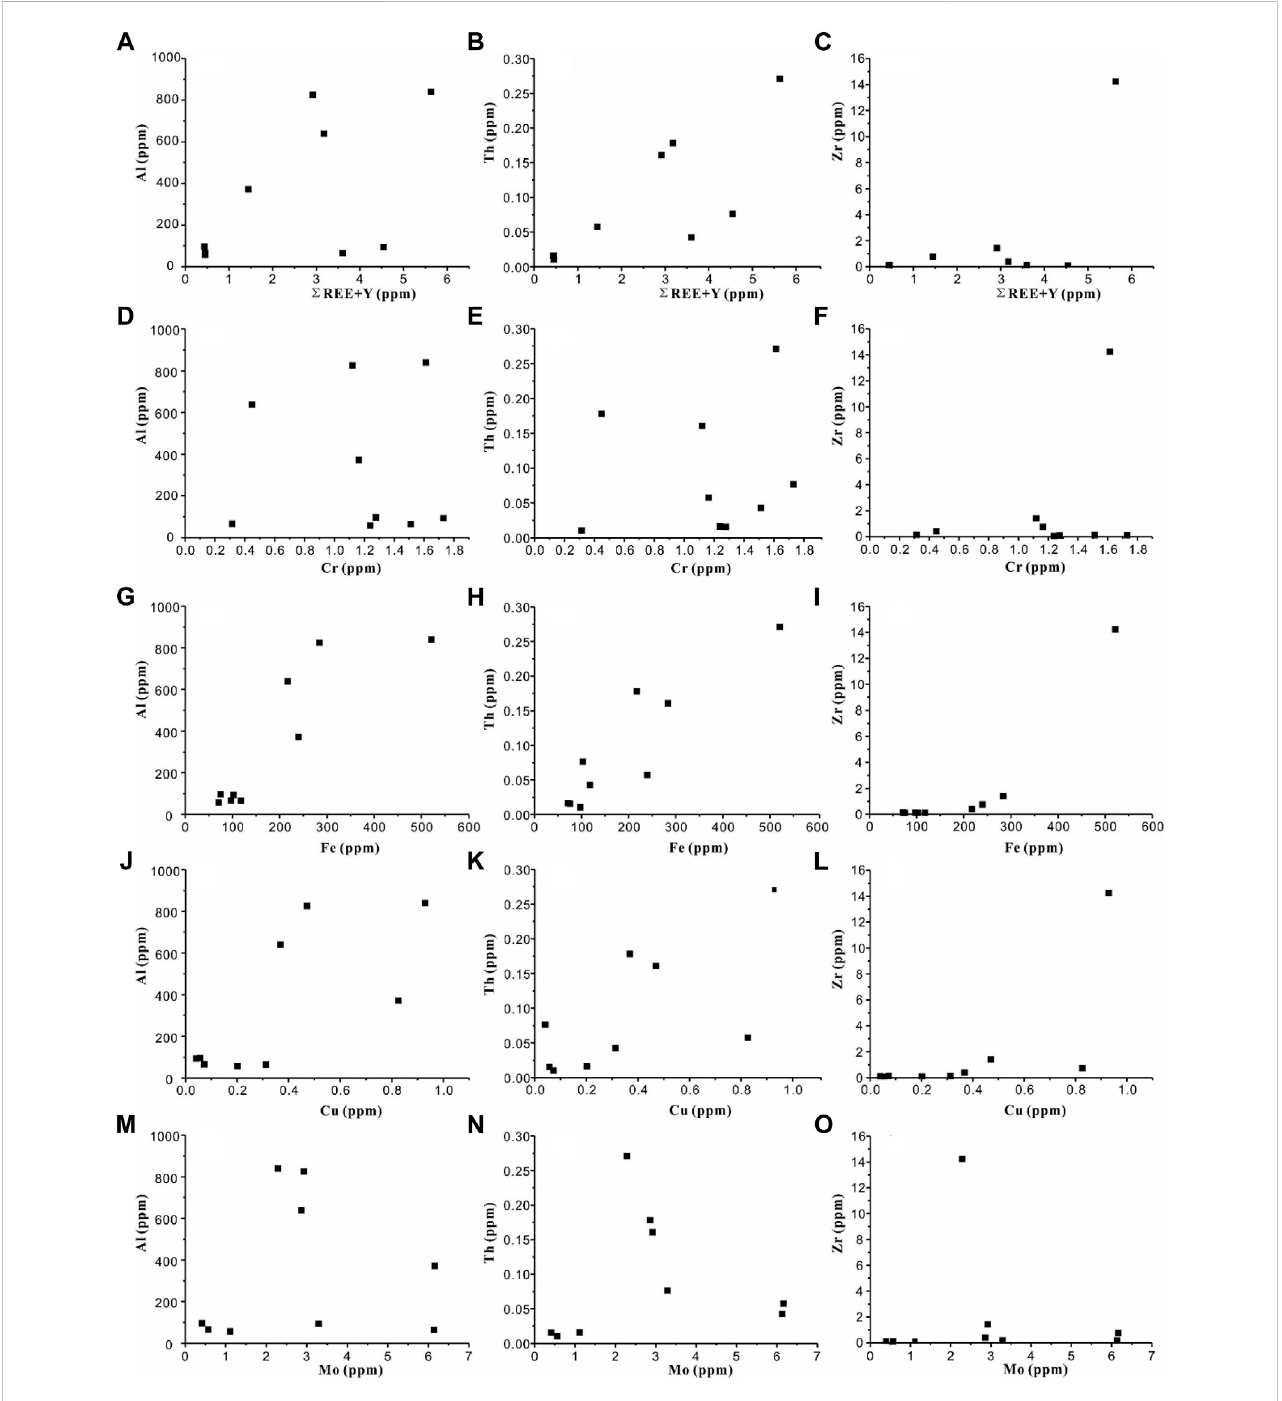
FIGURE 5 Cross plots of Al, Th and Zr versus Σ REE+Y (A – C) , Cr (D – F) , Fe (G – I) , Cu (J – L) , and Mo (M – O)